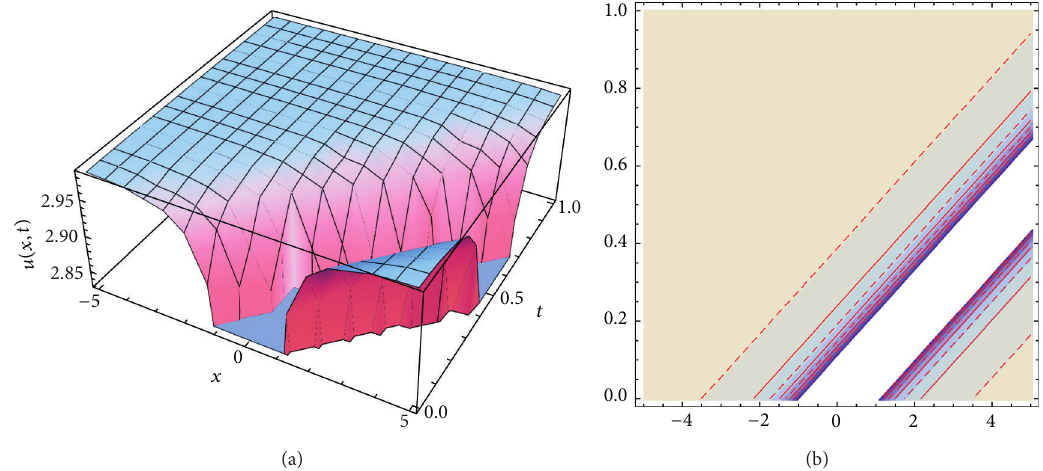
Figure 6: (a) Travelling waves solutions of (39) is plotted: stability dark solitary waves. (b) Travelling waves solutions of (39) is plotted: stability contour of solitary